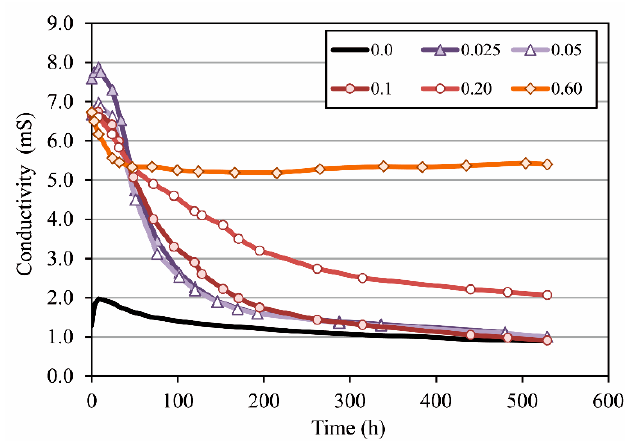
ff erent lime / fly ash